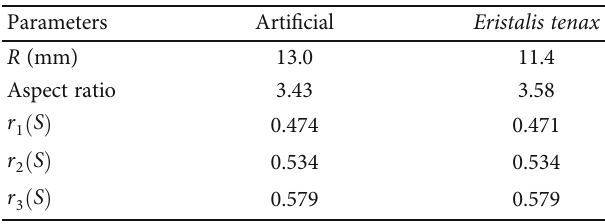
Table 2: Morphological parameters of the arti fi cial wing and the Eristalis tenax wing [25].